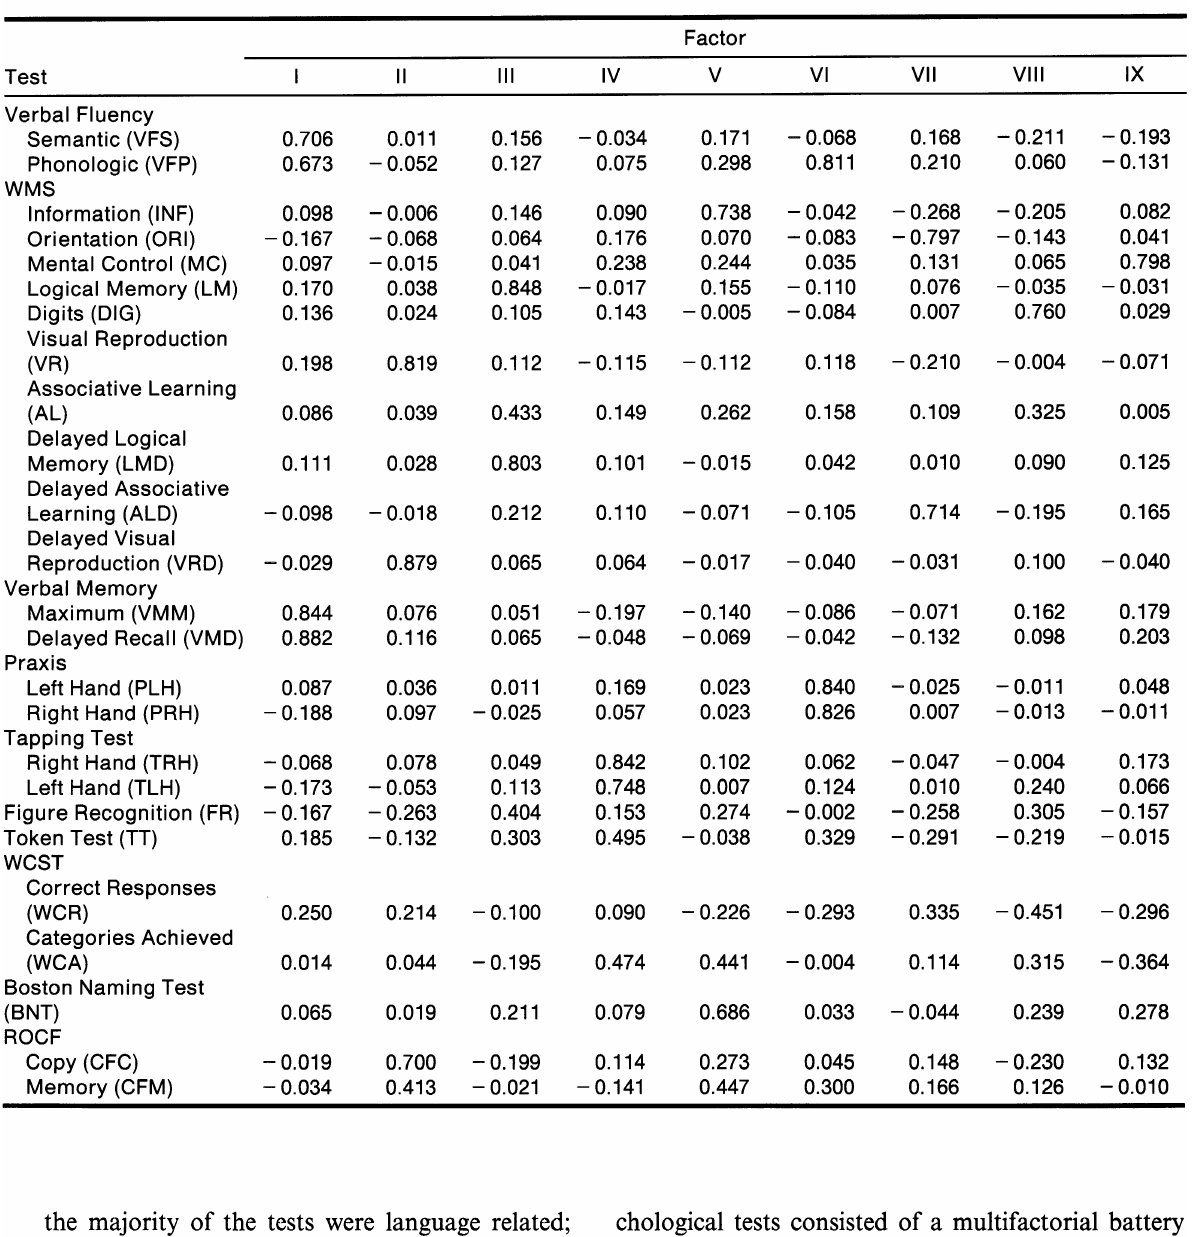
TABLE V. Correlations between the different tests and the nine factors